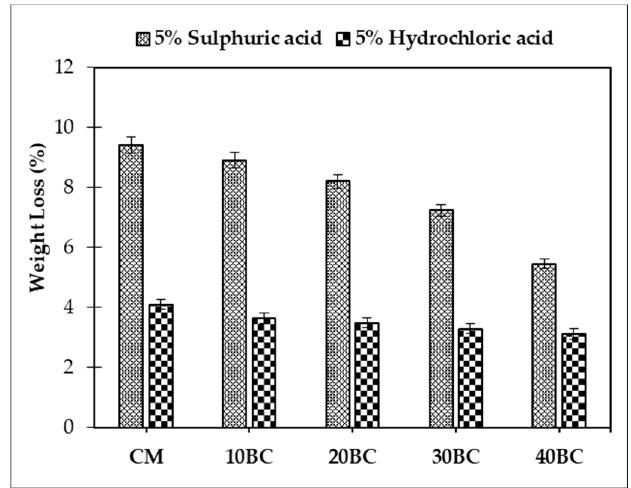
Buildings 2022 , 12 , x FOR PEER REVIEW Figure 14. Weight loss of concrete mixes subjected to acid attack. Figure 14. Weight loss of concrete mixes subjected to acid attack.